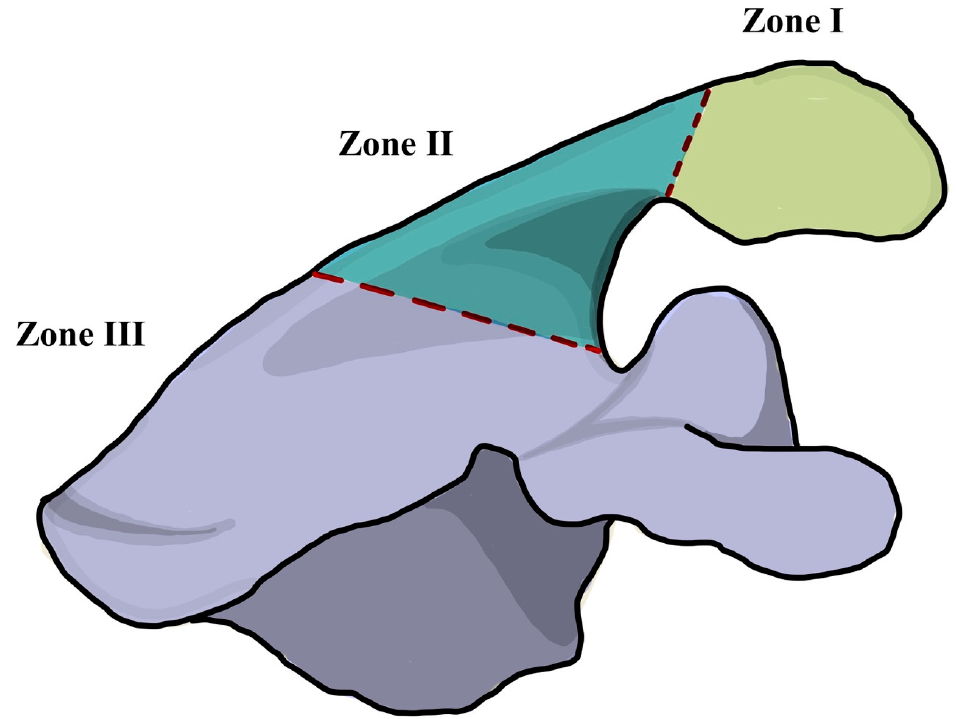
Figure 1. Illustration of the Levy classification for acromial stress fractures after reverse total shoulder arthroplasty [20]. Zone I involves a fracture through the midpart of the acromion caused by the anterior and middle deltoid origin. Zone II was defined as a fracture caused by the entire middle deltoid segment and portion of posterior deltoid origin. Zone III fractures involve the entire middle and posterior deltoid